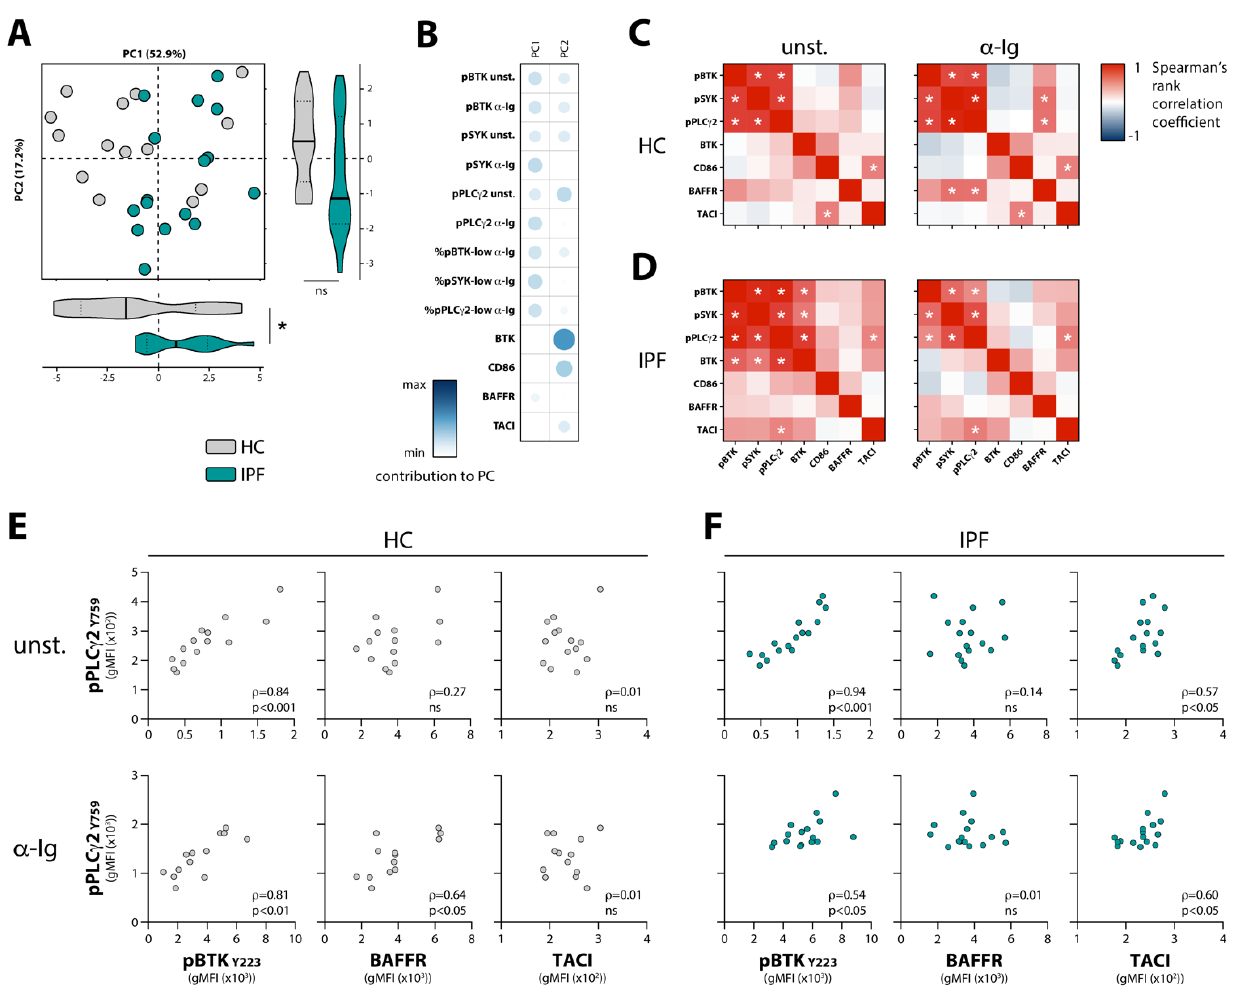
Figure 2. Correlation analysis of ex vivo measured B cell markers and in vitro measured phosphorylation of BCR signalosome molecules in naïve (CD3 − CD19 + CD38 lo CD27 − IgD + ) B cells from HCs and IPF patients (cohort 1). ( A ) Principal component analysis (PCA) of BCR signalosome molecules and B cell activation markers and ( B ) the individual contribution of each variable to PC1 and PC2 from IPF and HC naïve B cells. ( C , D ) Spearman’s rank correlation matrix for ( C ) HCs and ( D ) IPF patients for the indicated markers measured ex vivo and phosphorylated proteins of unstimulated (unst.) and BCR-stimulated ( α -Ig) naïve B cells. ( E , F ) Spearman’s rank correlation analysis of ( E ) HCs and ( F ) IPF patients for the correlation of pPLC γ 2 with pBTK, BAFFR, and TACI in unstimulated (unst.) and BCR-stimulated ( α -Ig) naïve B cells. Subjects are indicated by individual data points. * p < 0.05 in ( A ) by an unpaired two-tailed Student’s t -test; ns, not